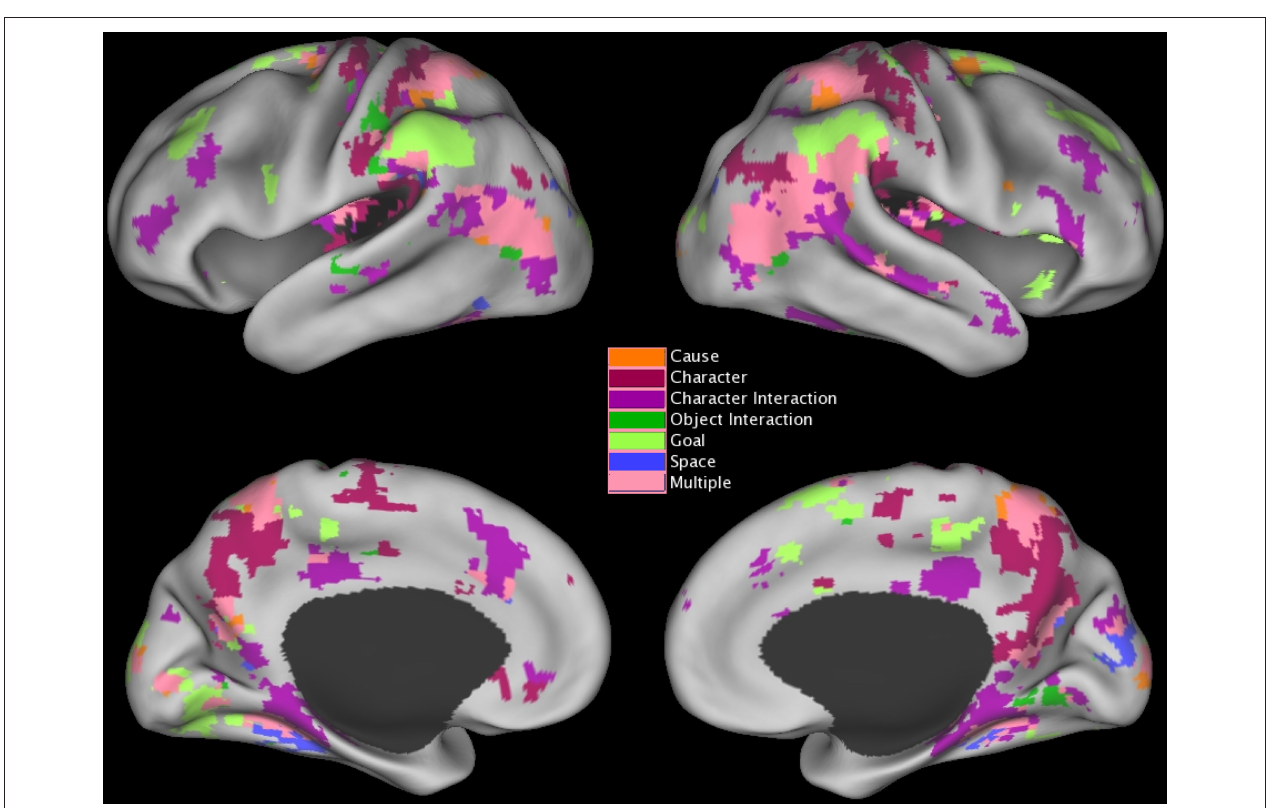
FIGuRE 3 | Distribution of brain areas with significant transient changes at event boundaries, projected on inflated renderings of the cortical hemispheres using CARET (Van Essen et al., 2001) and the PALS cortical surface atlas (Van Essen, 2005) . Coloring shows the z statistic value at each